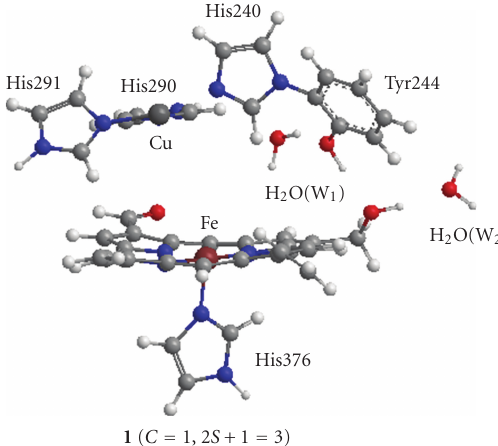
Figure 1: Model of catalytic site in fully reduced form of bovine heart cytochrome c oxidase (1OCR in PDB). The added two water molecules W 1 and W 2 are detailed in